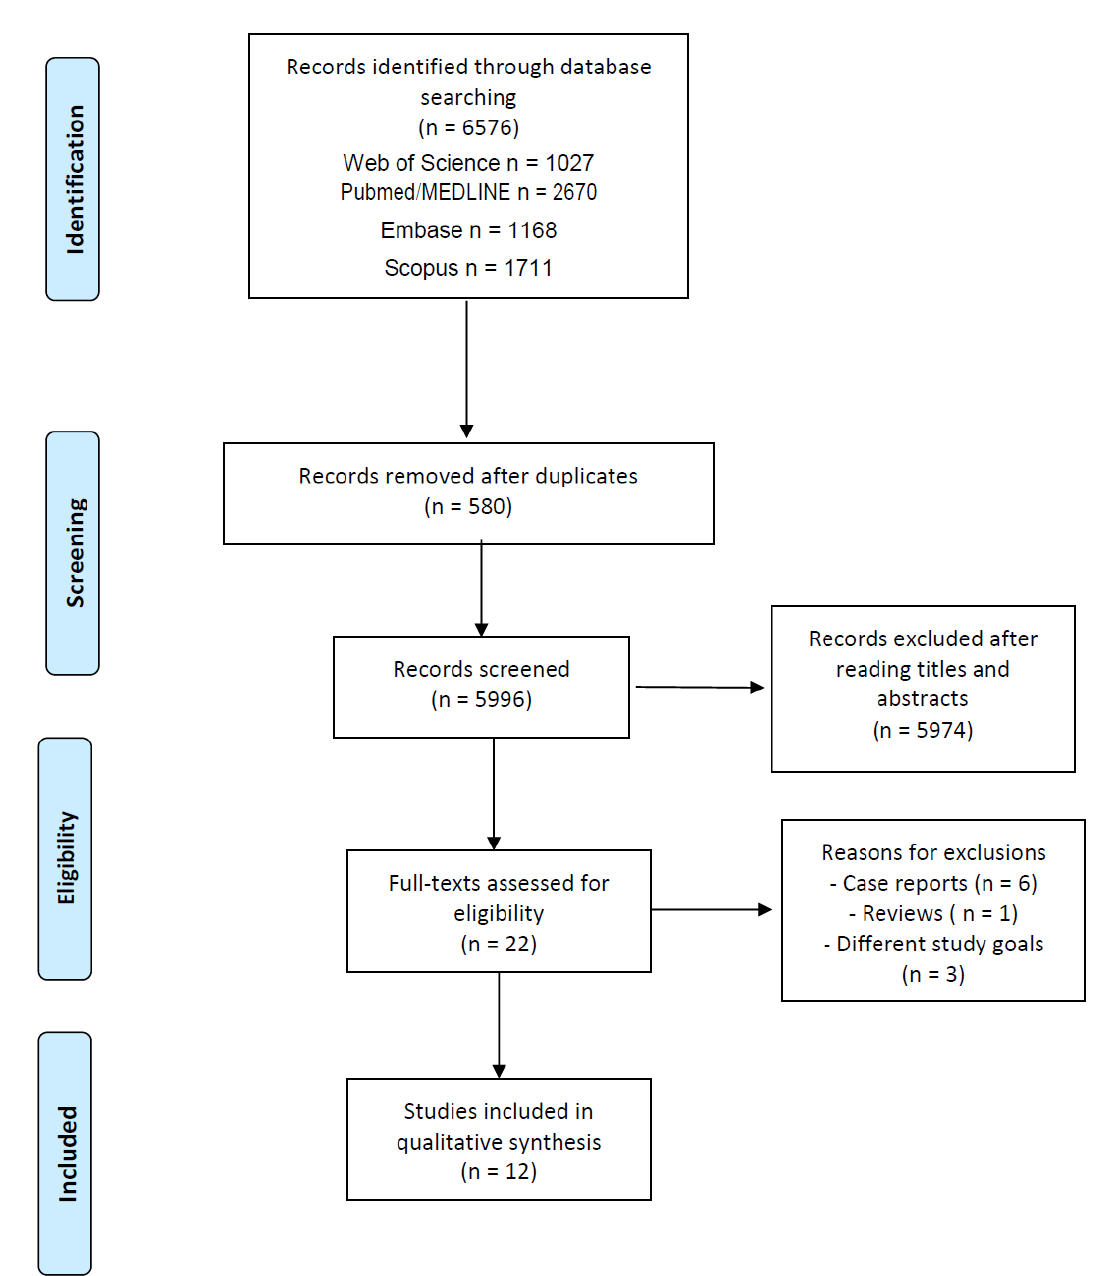
Figure 1. Information flow diagram of the phases of the systematic review, based on PRISMA pro- tocol (n = number of